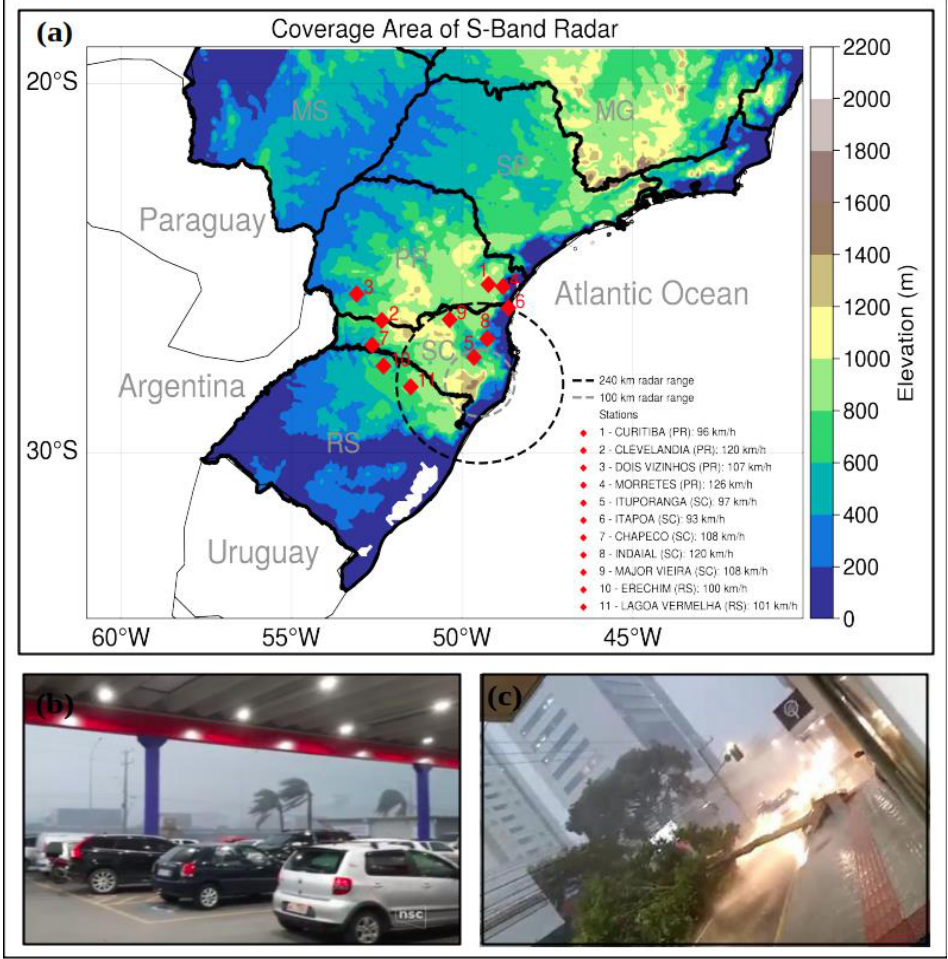
Figure 1. ( a ) Location of Rio Grande do Sul (RS), Santa Catarina (SC) and Paraná (PR) states in Brazil, and of the maxima winds recorded at the meteorological stations on 30 June 2020, which were mostly observed between 1600 and 2000 UTC; ( b , c ) Examples of damage caused by the squall line associated with the cold front on 30 June, between 1800 and 2000 UTC, in SC. In ( b ), the photograph was taken in the city of Indaial, east of SC; and in ( c ), the photograph was taken in Ituporanga, central–eastern zone of SC. Photos available at https://g1.globo.com/sc/santa-catarina/noticia/2020/ (accessed on 20 February 2022).